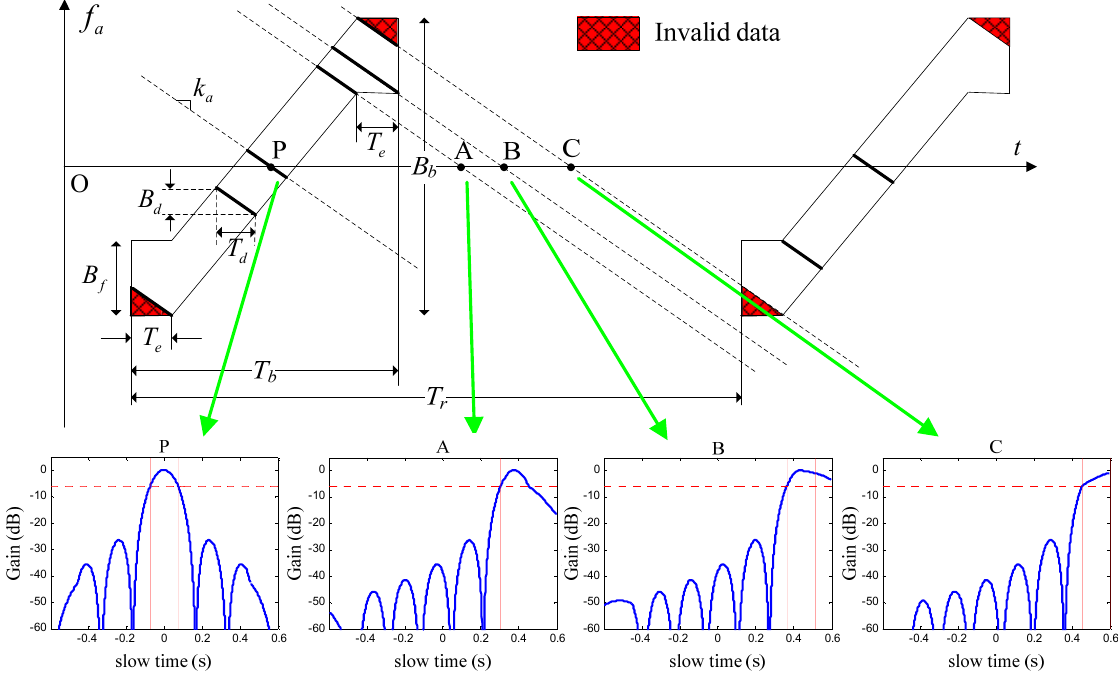
Figure 8. The Extended Terrain Observation by Progressive Scans (ETOPS) timeline in the azimuth time-frequency